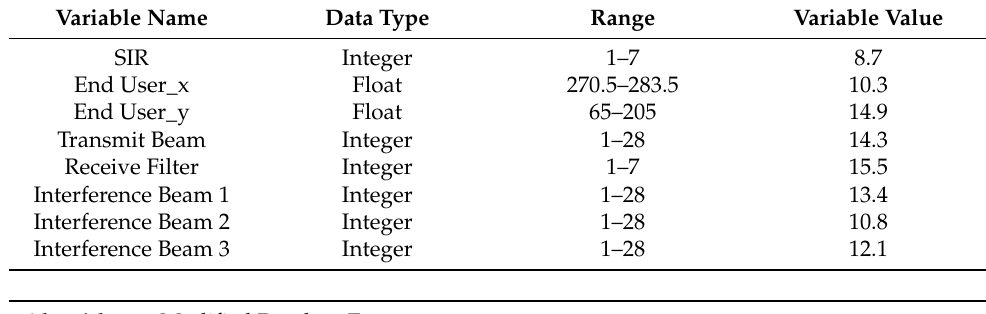
Table 2. Contribution value and data type of input attributes.